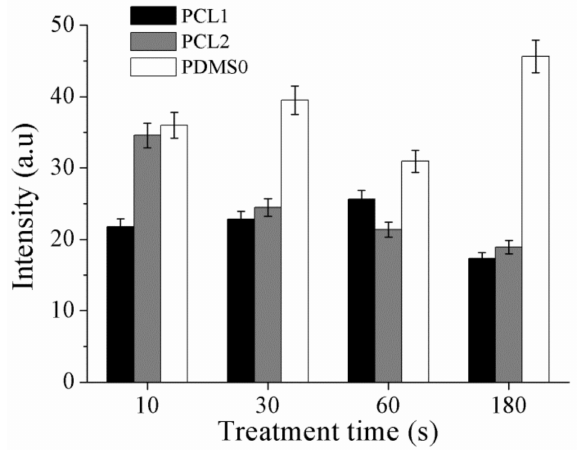
Figure 8. The fluorescence intensity of FITC-bovine serum albumin (FITC-BSA) adsorbed on PCL and PDMS after CF 4